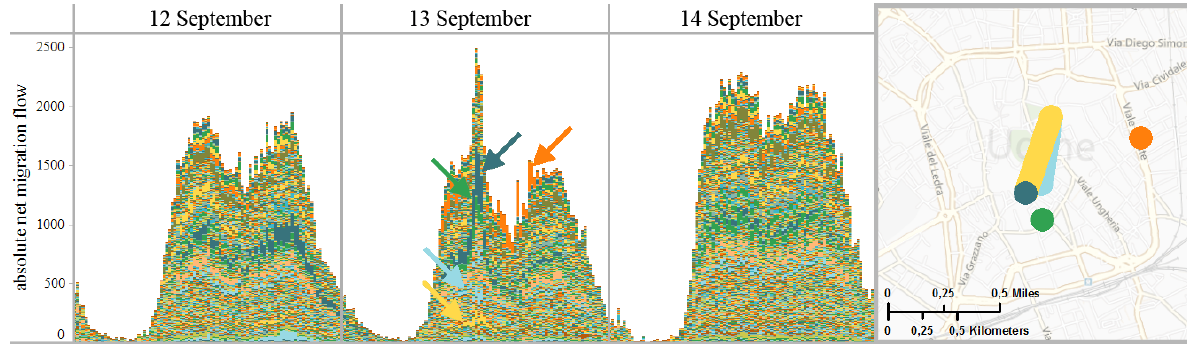
Figure 10. Celebration of the 60th anniversary of mountain infantry in Udine on Sunday, 13 September 2009 (the color of the arrows correspond with the color in the